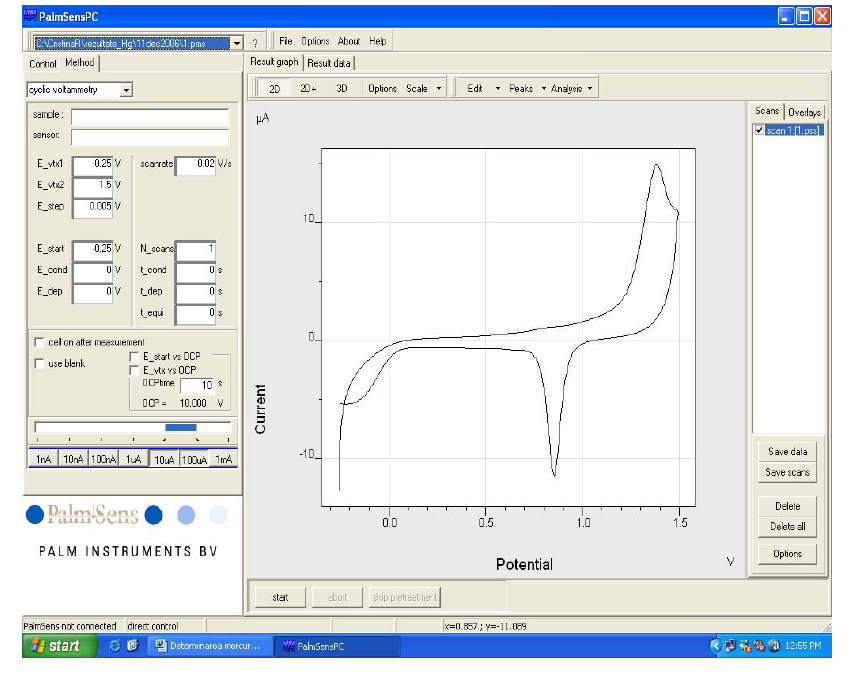
Figure 3 . Cyclic voltammogram registered with a gold electrode prepared from a CD in a SO solution. Potential scanning was in the domain -0.25 V to +1.5 V and 0.2 M H 2 4 scanning rate was 0.02